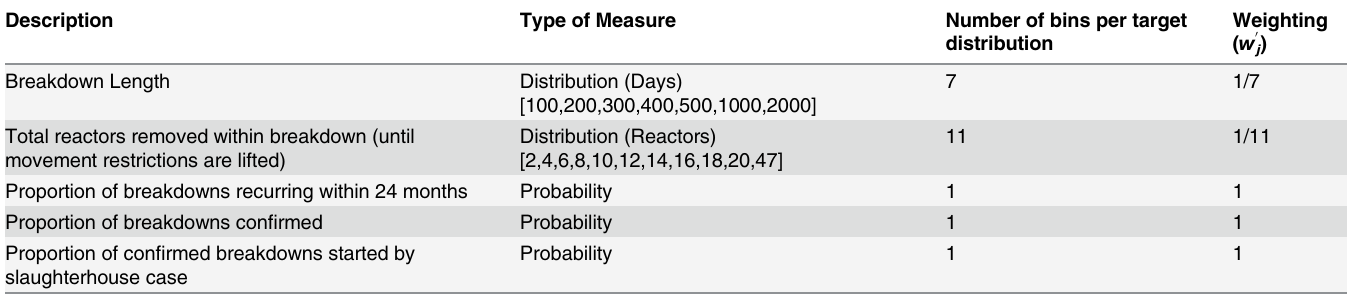
Table 5. Epidemiological target measures for ABC.